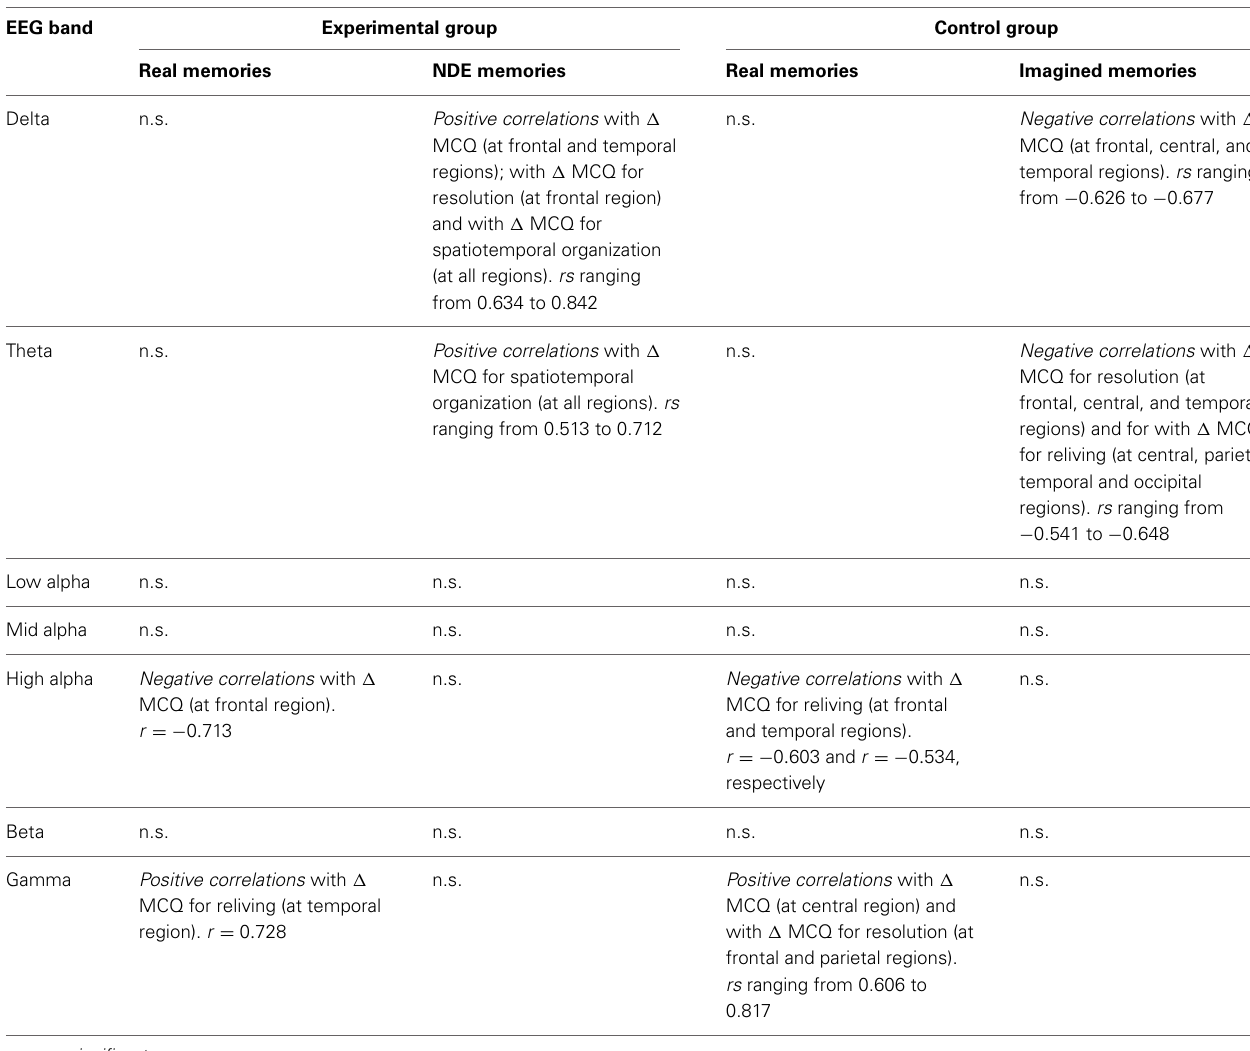
Table 2 | Pattern of correlations between each EEG band and (cid:2) MCQ